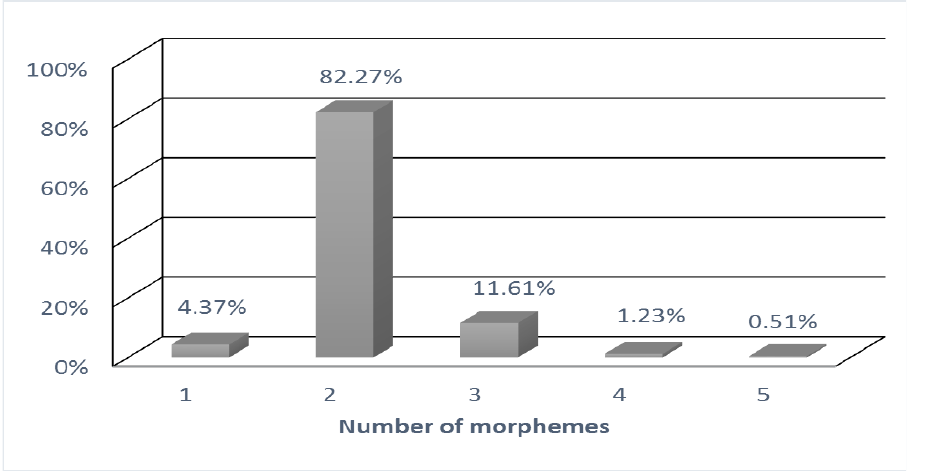
Figure 4. Percentage of Pronouns with a Different Number of